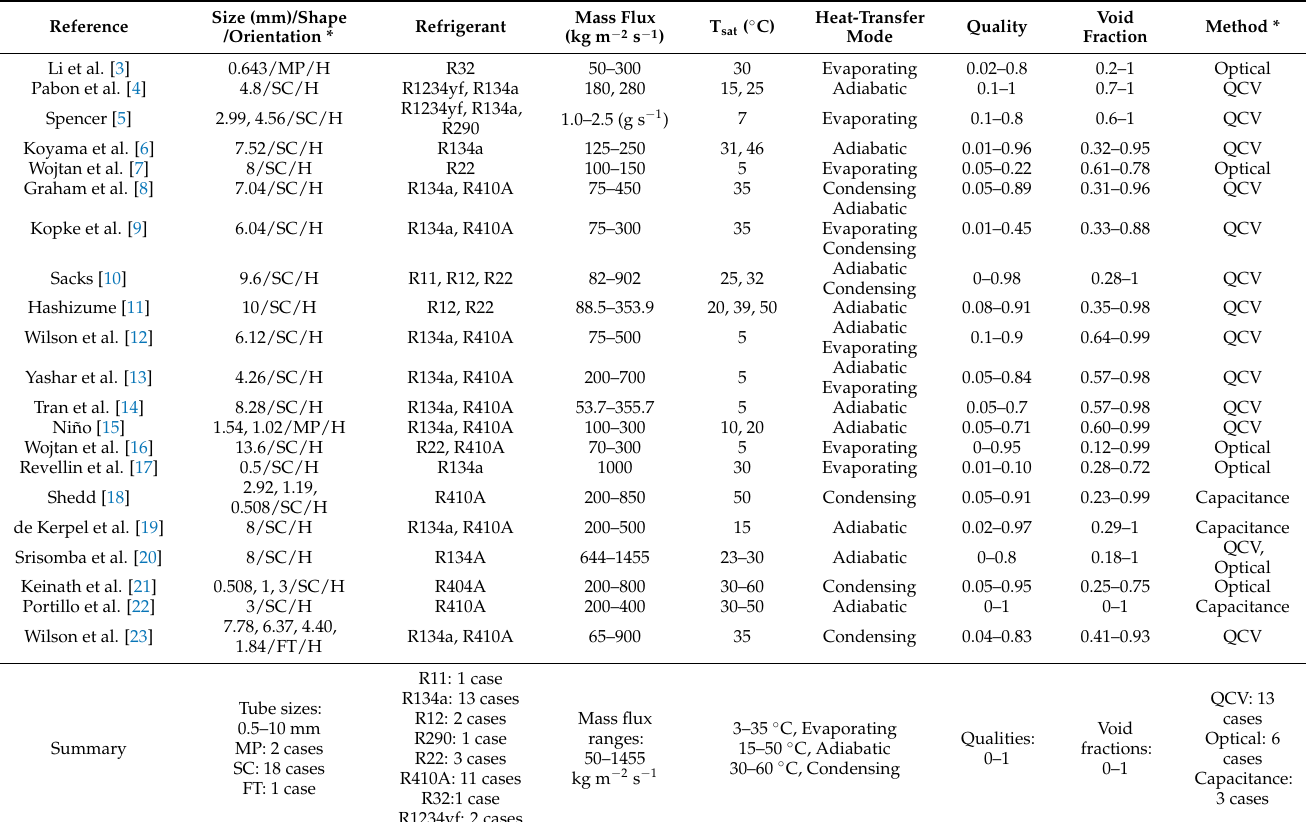
Table 1. Summary of reported void fraction measurement results for